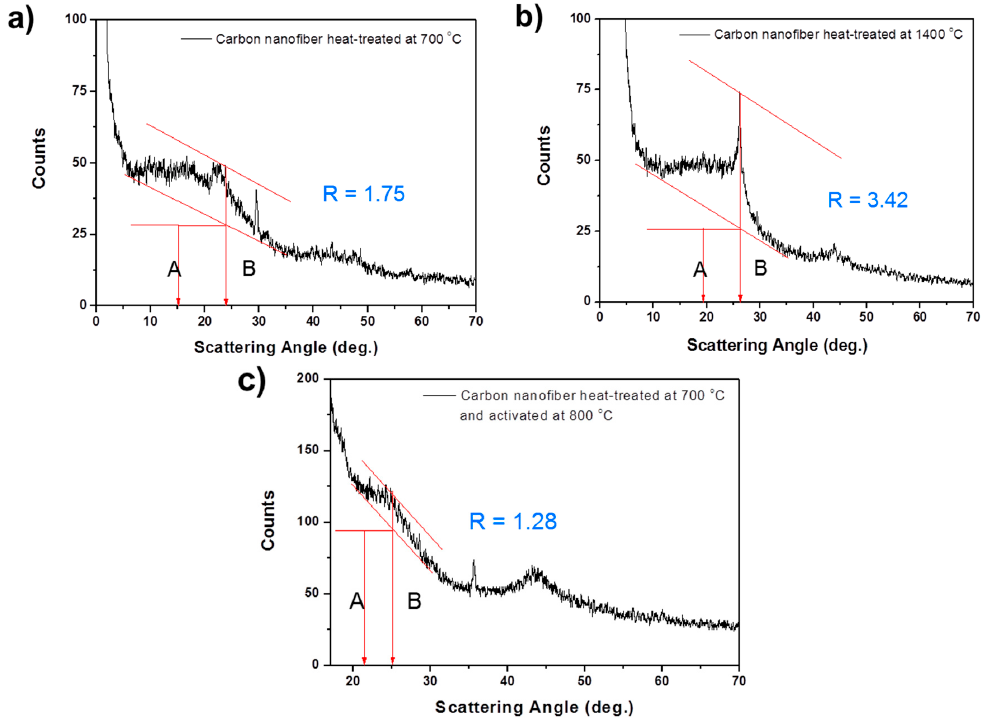
Figure 5. X-ray diffraction analysis for estimating the fraction of single-layers in carbon nanofibers heat-treated at ( a ) 700 °C; ( b ) 1400 °C; and ( c ) 700 °C; and activated at 800 °C. heat-treated at ( a ) 700 ◦ C; ( b ) 1400 ◦ C; and ( c ) 700 ◦ C; and activated at 800 ◦